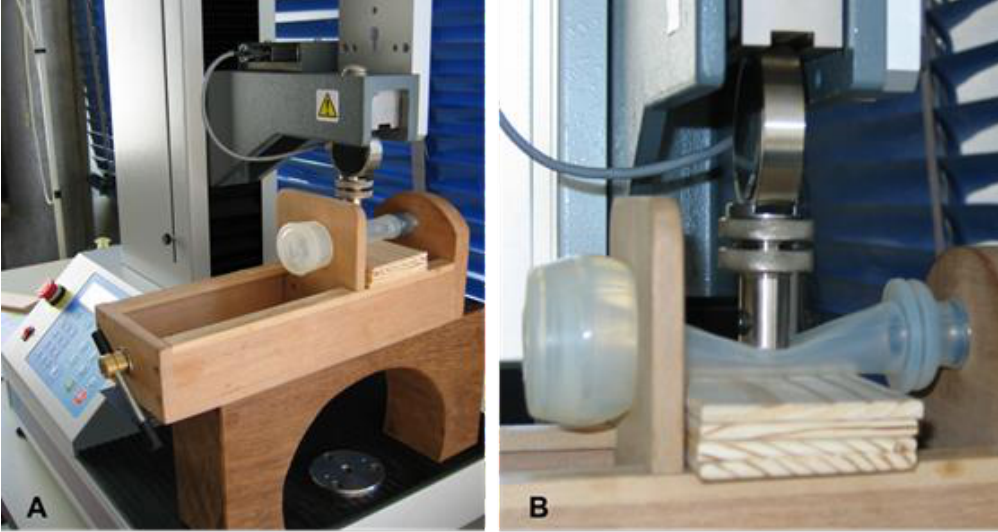
Figure 2. Universal material testing stand LF Plus and liner extension tool ( A ) while testing liner’s touch point pressure ( B